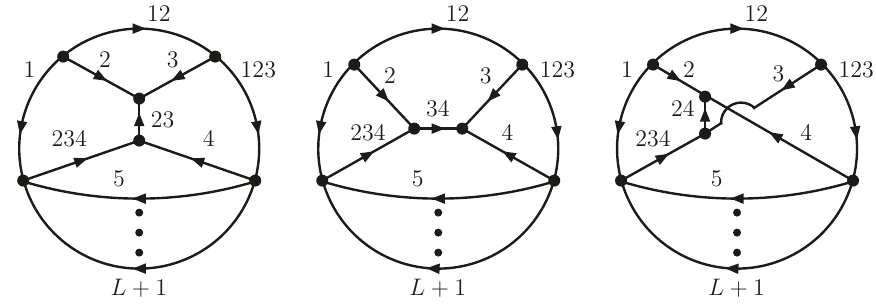
Figure 1 . Diagrams of the N 4 MLT family. The diagram on the l.h.s. corresponds to the t channel, the diagram on the center is the s channel and the diagram on the r.h.s. corresponds to the u channel. An arbitrary number of external particles (not shown) are